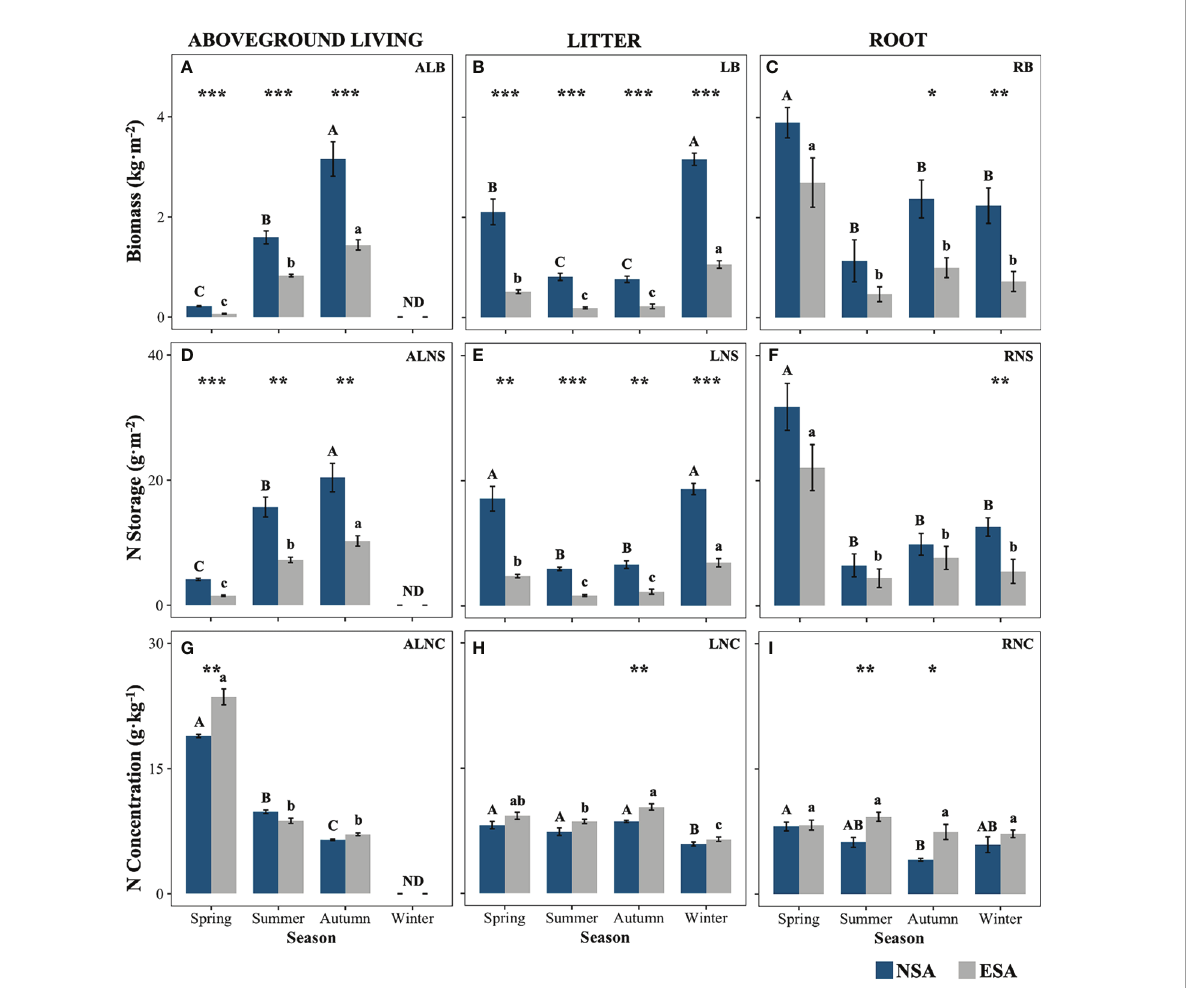
FIGURE 2 Values of (A – C) biomass, and nitrogen (D – F) storages and (G – I) concentrations of various Spartina alterni fl ora tissues in natural (NSA) and embanked (ESA) salt marshes in spring, summer, autumn, and winter. ALB, aboveground living biomass; ALNS, aboveground living nitrogen storage; ALNC, aboveground living nitrogen concentration; LB, litter biomass; LNS, litter nitrogen storage; LNC, litter nitrogen concentration; RB, root biomass; RNS, root nitrogen storage; RNC, root nitrogen concentration. The averages and standard errors of four replicates are shown. Bars labelled with different uppercase and lowercase letters denote signi fi cant differences ( p < 0.05) between seasons in NSA and ESA, respectively. The differences between NSA and ESA were signi fi cant at *** p < 0.001, ** p < 0.01 and * p < 0.05, and blanks indicate no signi fi cance at p ≥